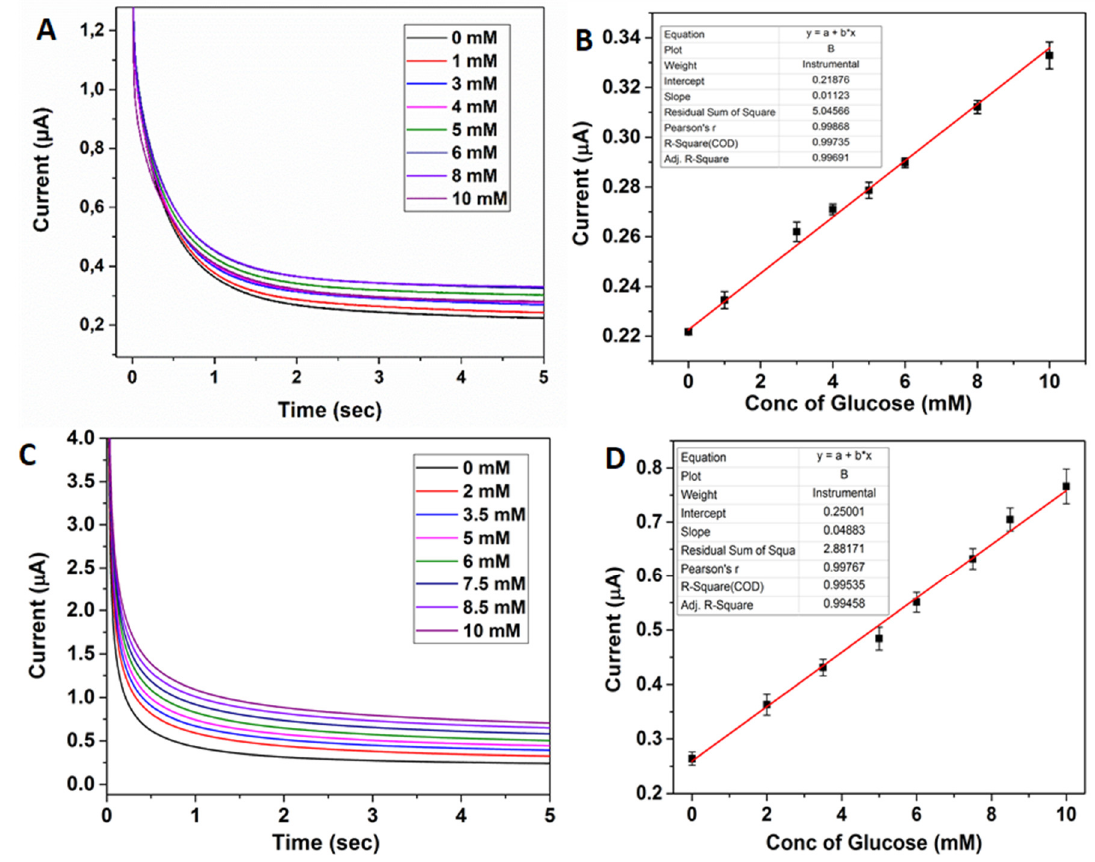
Figure 4. ( A ) Chronoamperometric sensing of glucose (0–10 mM) with 2D/RGO-PEI/GOx pyrolytic carbon electrodes in 10 mM PBS (pH 7) ( B ) Corresponding calibration plot obtained from concentration of glucose vs. current at 4 s. ( C ) Chronoamperometric sensing of glucose (0–10 mM) with 3D/RGO-PEI/GOx pyrolytic carbon electrodes in 10 mM PBS (pH 7) ( D ) Corresponding calibration plot obtained from concentration of glucose vs. current at 4 s.